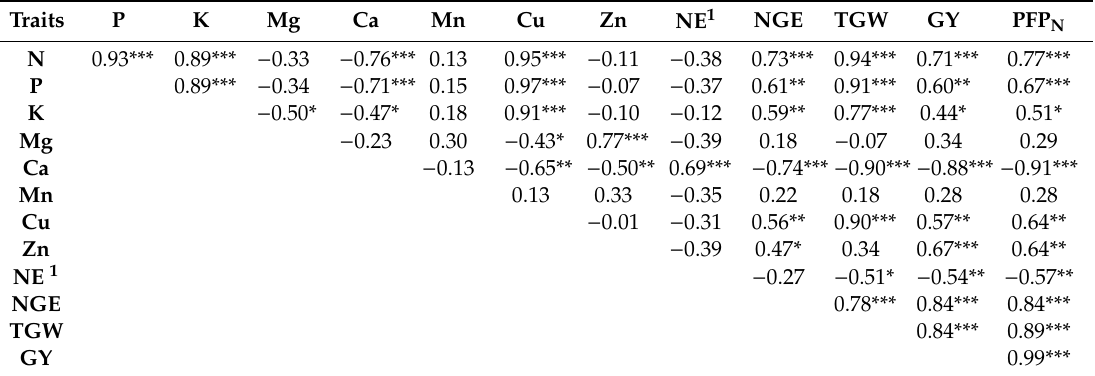
Table 4. Correlation matrix between contents of nutrients in leaves of spelt wheat, yield components and yield traits, n =